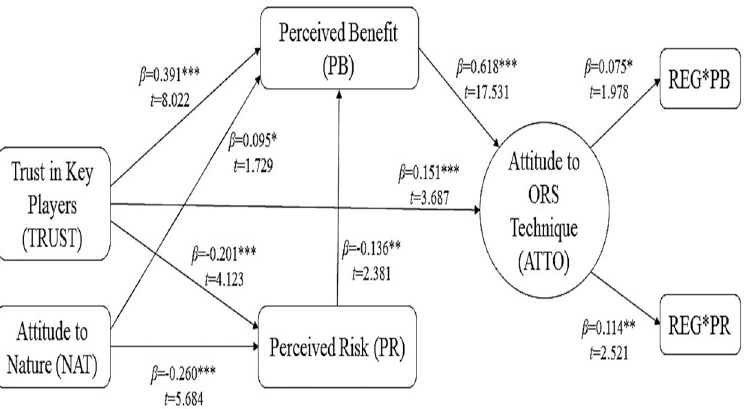
Fig 2. Results of the structural model analysis for predicting factors and religiosity as a moderator in understanding the attitudes of stakeholders towards the ORS technique.